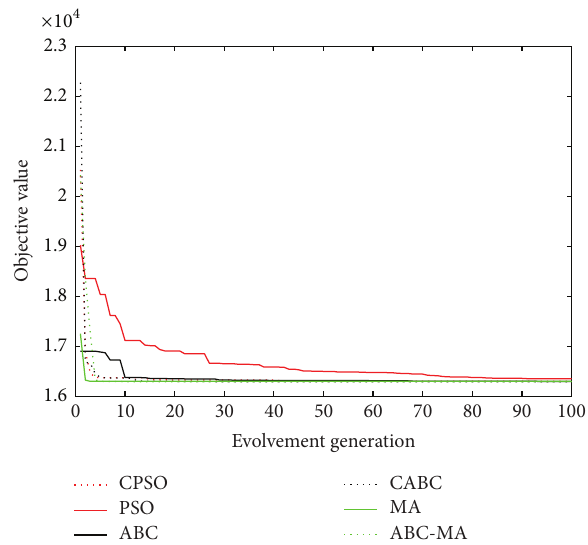
Figure 10: The convergence curve of the wine data.